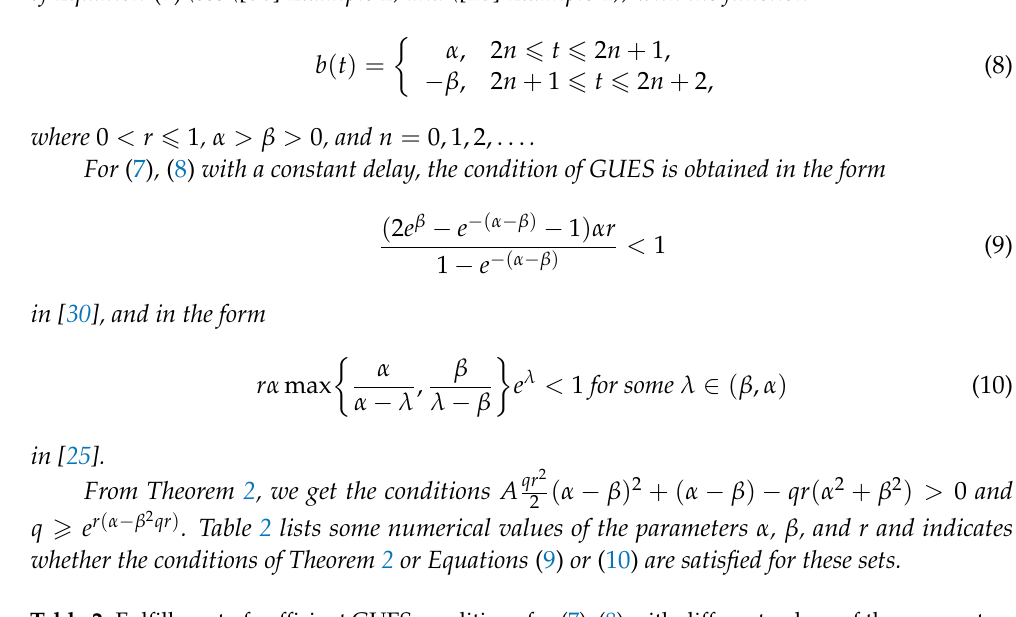
Table 2. Fulfillment of sufficient GUES conditions for (7), (8) with different values of the parameters α , β , and r